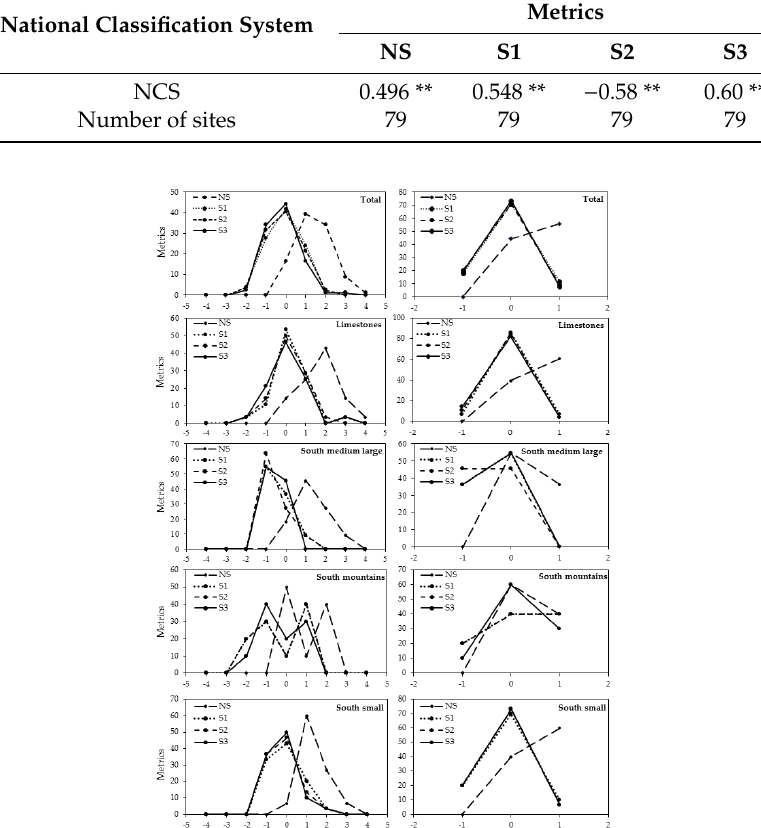
Figure 5. Comparison of metric classifications (NS, S1, S2, S3) with the NCS classification. Negative numbers correspond to underevaluations, 0 corresponds to correct evaluations, and positive numbers correspond to overevaluations. The absolute values on the x-axis correspond to the number of classes the metric classification differs from the NCS classification. The y-axis corresponds to the frequency of the underevaluations, correct evaluations, and overevaluations. The graphs in the left column correspond to five ecological quality classes. Graphs on the right correspond to two ecological quality classes. The results are reported for the all the sites and for each river type. No more than 18% of the classifications obtained by S1, S2, and S3 for the two ecological quality classes, assuming an uncertainty of 5% around the boundary (Figure 6a–e), are incorrect. Once again, the river types with the lowest number of sites (south mountains and large–medium river types) do not fit into these